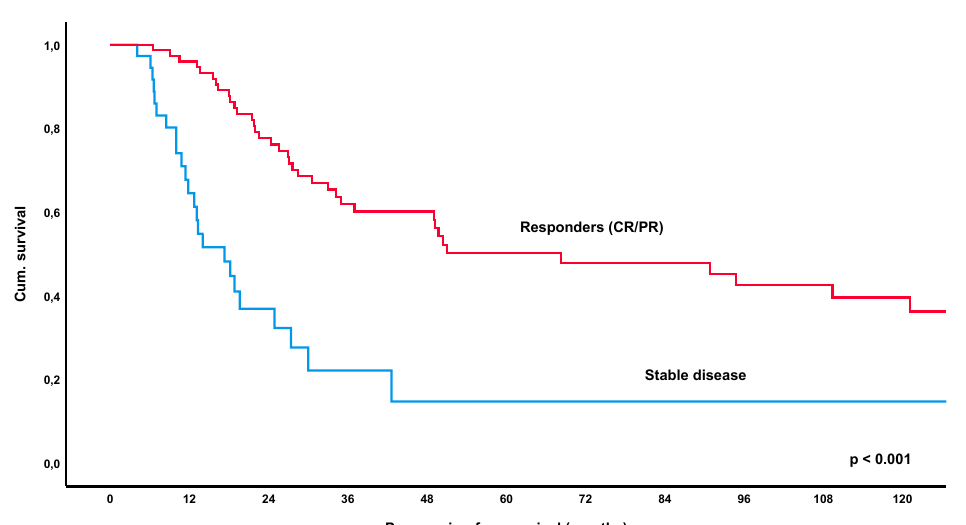
Figure 1. Kaplan-Meier curve for progression-free survival following first-line treatment for patients with gastric mucosa-associated lymphoid tissue (MALT) lymphoma. Abbreviations: CI = confidence interval.